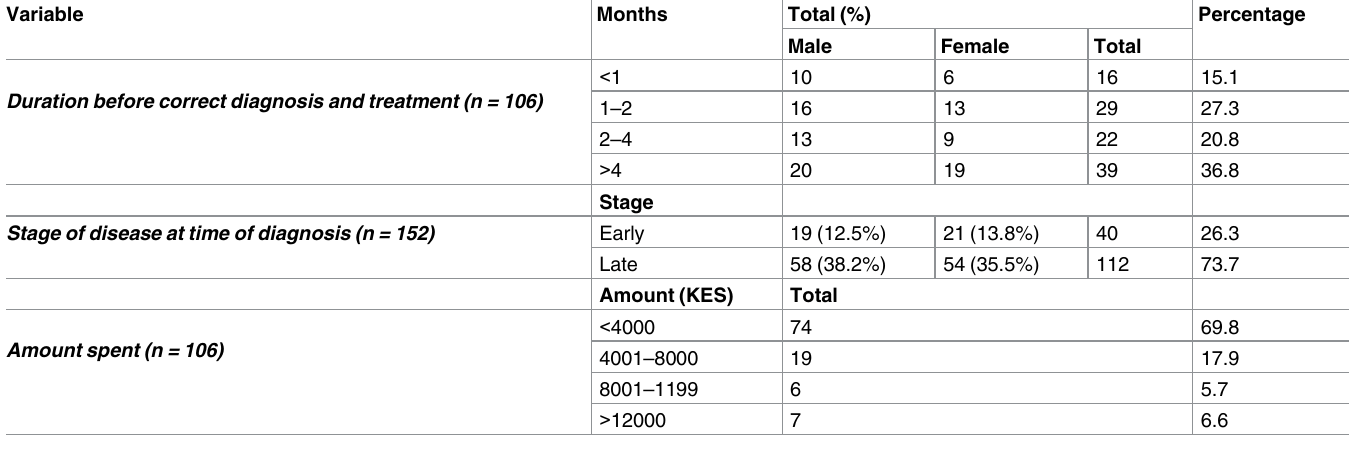
Table 2. Health seeking behaviour in relation to HAT in south western Kenya HAT